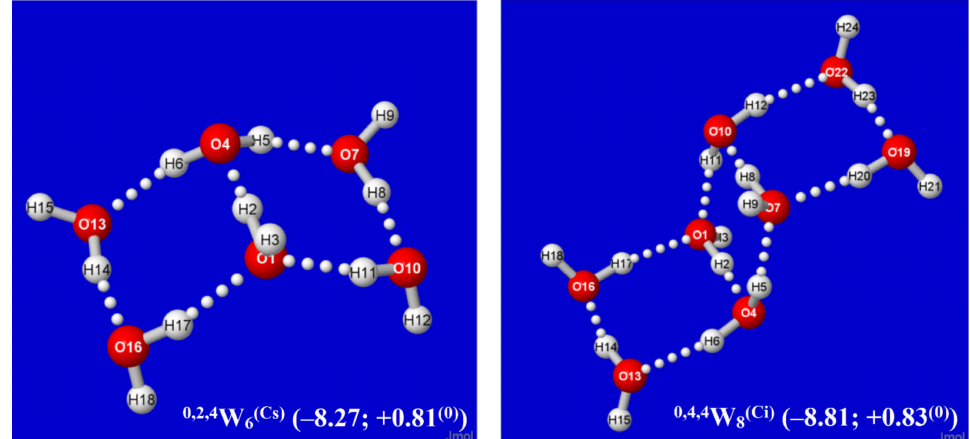
Figure 4. Alternative higher-symmetry 0,2k,4 W 2k+4(sym) clusters ( k = 1,2), one ( C s ) of higher energy, the other ( C i ) of lower energy than the corresponding low-symmetry structure of Figure